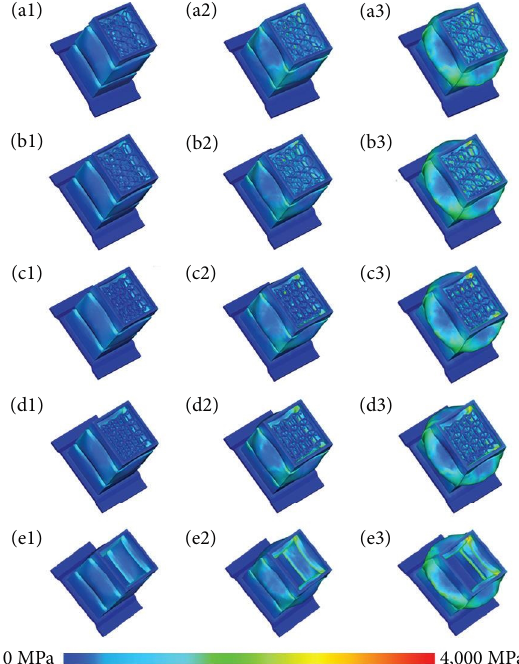
F IGURE 7: The deformation and stress of automotive energy absorbing box: (a 1 – a 3 ) HS automotive energy absorbing box stress distribution diagrams at compression strain of 0.105, 0.204, and 0.285; (b 1 – b 3 ) AHS automotive energy absorbing box stress distribution diagrams at compression strain of 0.105, 0.204, and 0.285; (c 1 – c 3 ) PS automotive energy absorbing box stress distribution diagrams at compression strain of 0.105, 0.204, and 0.285; (d 1 – d 3 ) APS automotive energy absorbing box stress distribution diagrams at compression strain of 0.105, 0.204, and 0.285; (e 1 – e 3 ) the automotive energy absorbing box stress distribution diagrams at compression strain of 0.105, 0.204, and